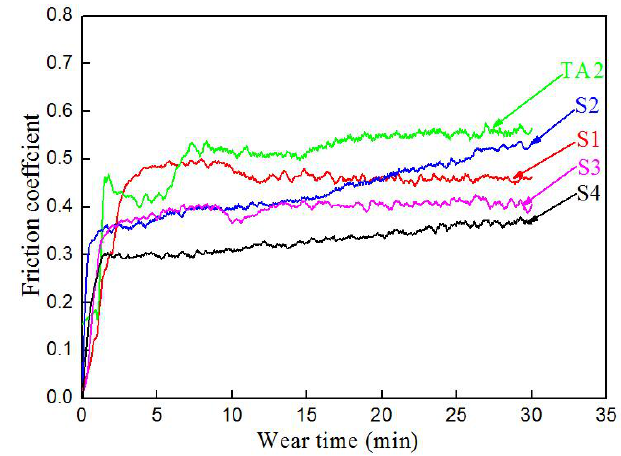
Figure 10. Friction coe ffi cient of samples S1–S4 and